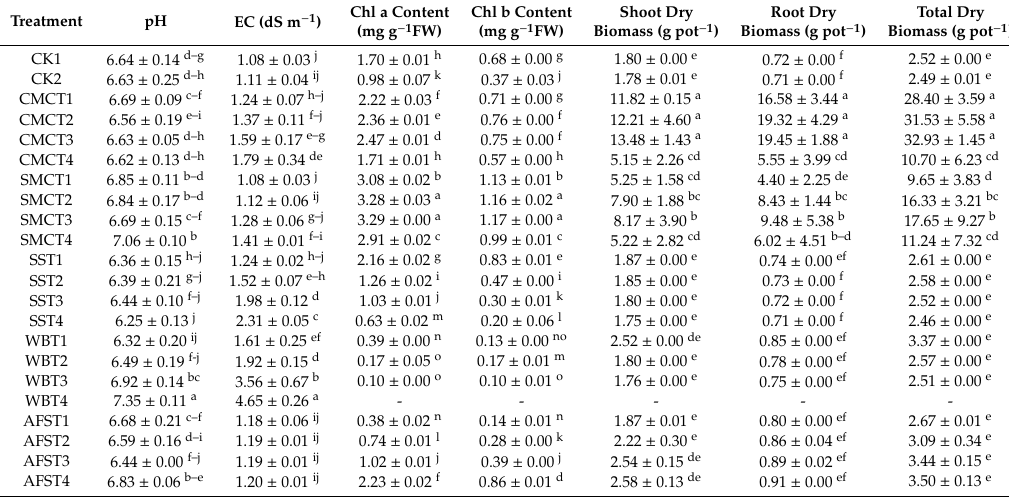
Table 1. E ff ect of di ff erent amendments on pH and EC of treated and untreated tailings samples; and chlorophyll (Chl) contents and plant dry biomass (mean ± standard deviation; n = 3) of A. fruticosa grown in treated and untreated tailings